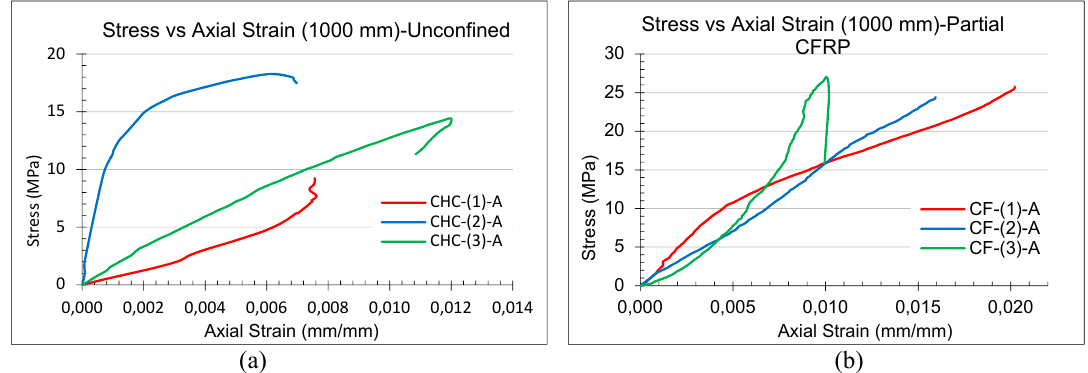
Figure 6. Stress vs Axial Strain; (a) Unconfined CHRCC (b) Partial CFRP CHRCC.